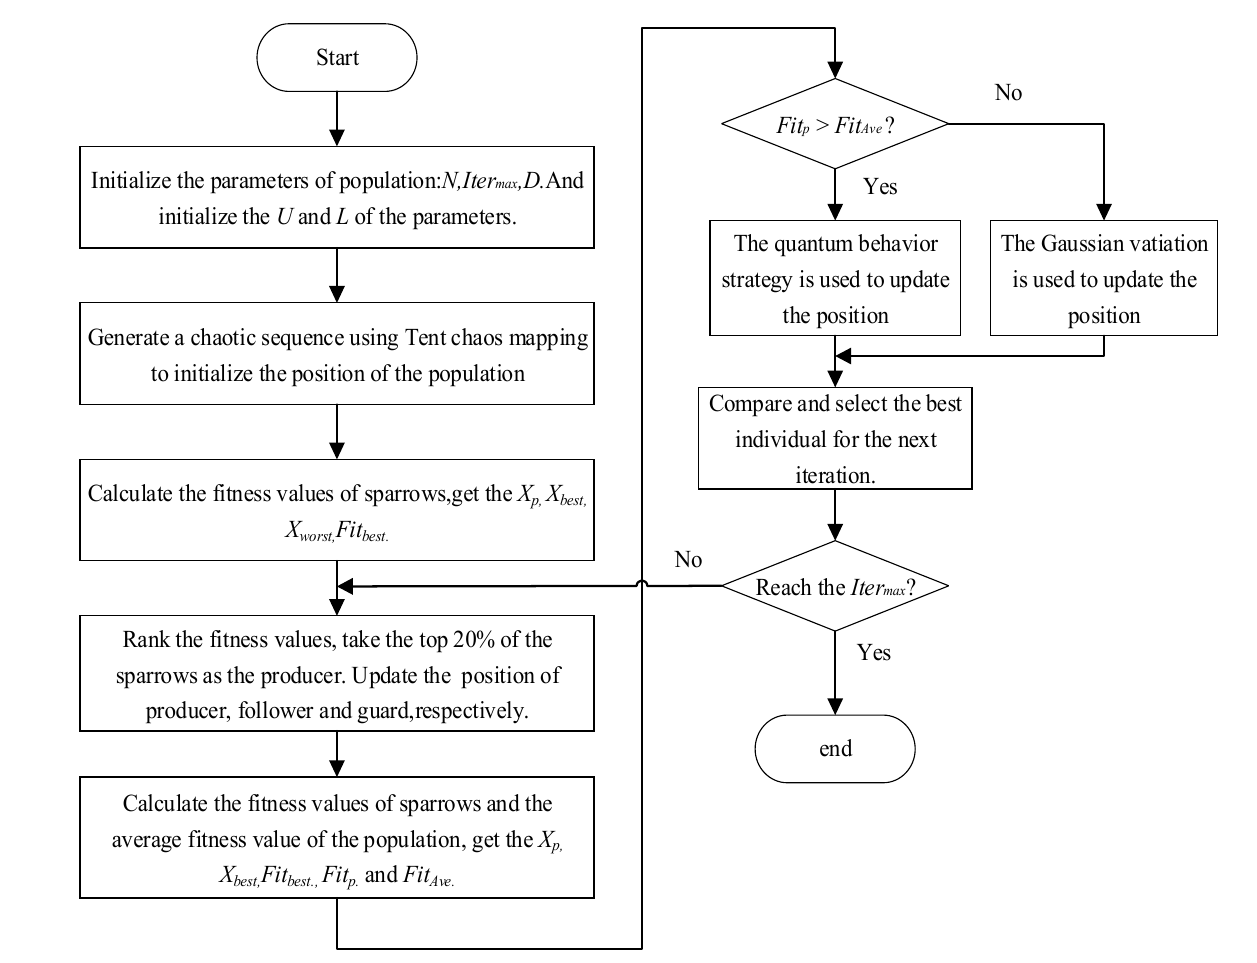
Figure 2. The algorithmic flow of the CQSSA algorithm. Table 1. Test Function (Dim =